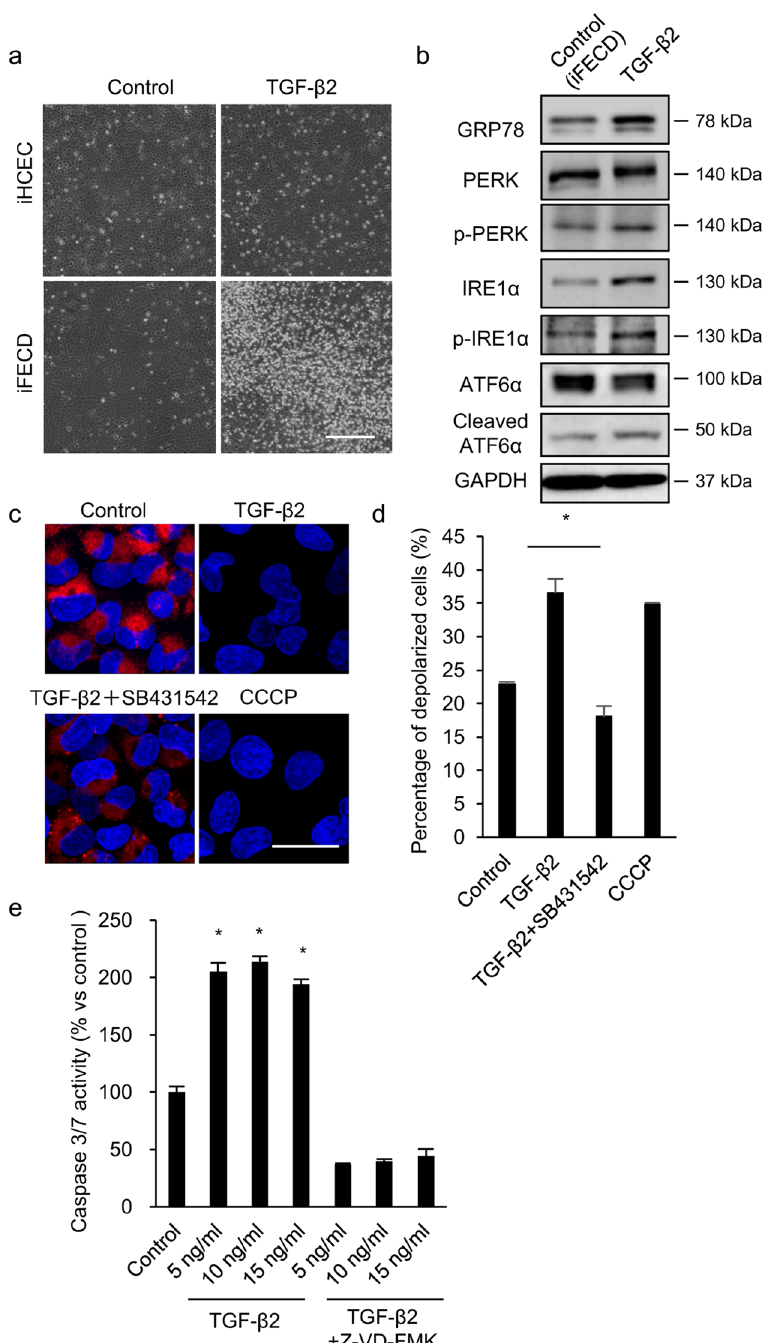
Figure 3. Activation of endoplasmic reticulum (ER) stress and subsequent intrinsic apoptotic pathway by TGF- β . ( a ) iFECD and iHCEC was cultured with or without TGF- β 2 (10 ng/ml) for 48 hours. Representative phase contrast images are shown. Experiments were performed in triplicate. Scale bar: 200 µ m. ( b ) iFECD was treated with TGF- β 2 for 6 hours and expression of GRP78, PERK, IRE1 α , and phosphorylation of PERK and IRE1 α , and cleavage of ATF6 α were evaluated by western blotting. Full-length blot of ATF6 α is presented in Supplementary Fig. 1. GAPDH was used as internal control. Experiments were performed in triplicate. ( c , d ) iFECD was treated with TGF- β 2, TGF- β 2 + SB431542 for 6 hours. After JC-1 staining, mitochondrial membrane potential (MMP) depolarization was evaluated by fluorescence microscopy and flow cytometry. Nuclei were stained with DAPI for fluorescence microscopy analysis. CCCP was used as positive control to induce MMP depolarization. Experiments were performed in triplicate. Scale bar: 50 µ m. The statistical analysis was performed by Student’s t-test. * P < 0.01. ( e ) iFECD was treated with TGF- β 2 (5, 10, or 15 ng/ml) for 6 hours with or without caspase inhibitor, Z-VD-FMK, then caspase 3/7 activity was determined by use of the Caspase 3/7 activity assay ® Luminescent Assay. Experiments were performed in duplicate. The statistical analysis was performed by Dunnett’s multiple comparisons test. * P <